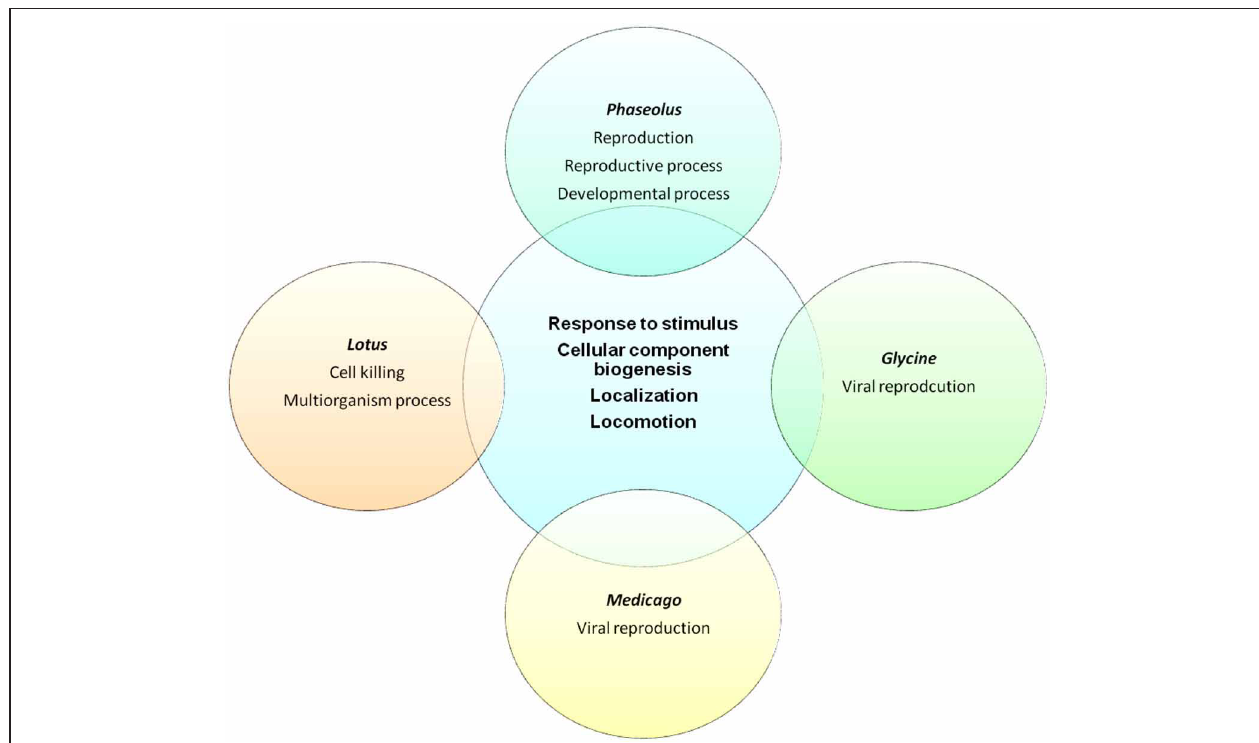
FIGURE 5 | Venn diagram representing the distribution of GO categories found in each legume genome. Around 15% of all sORFs in legumes were included in “response to stimulus” and close to 20% were related to “localization” GO categories. The